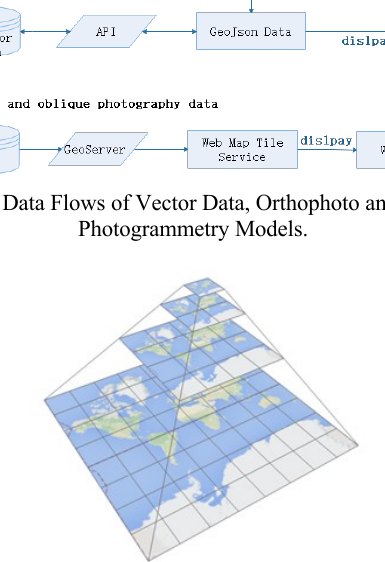
Figure 10 . Map Tile Service Diagram.